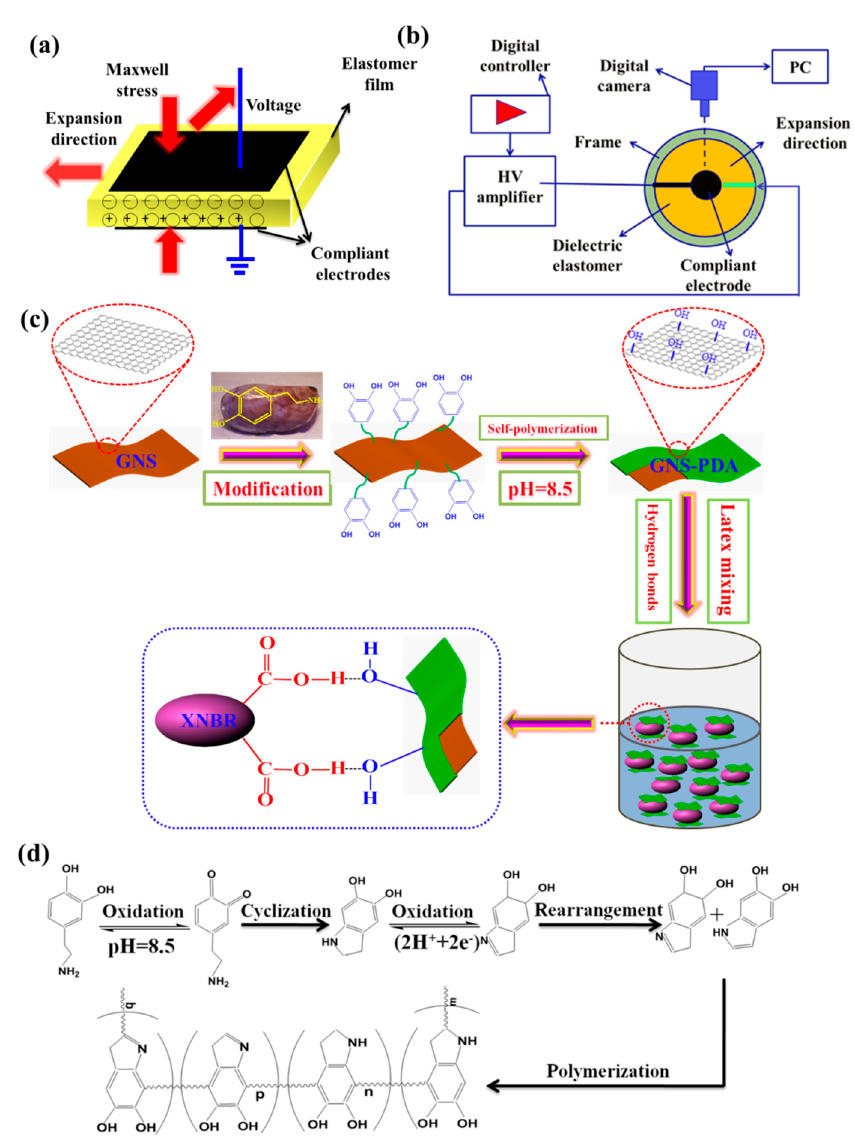
Figure 1. Schematic diagram of ( a ) dielectric elastomer actuator, ( b ) electromechanical testing method, ( c ) preparation of GNS-PDA nano-sheets and the GNS-PDA/XNBR composite; ( d ) Possible mechanism of dopamine oxidative self-polymerization.